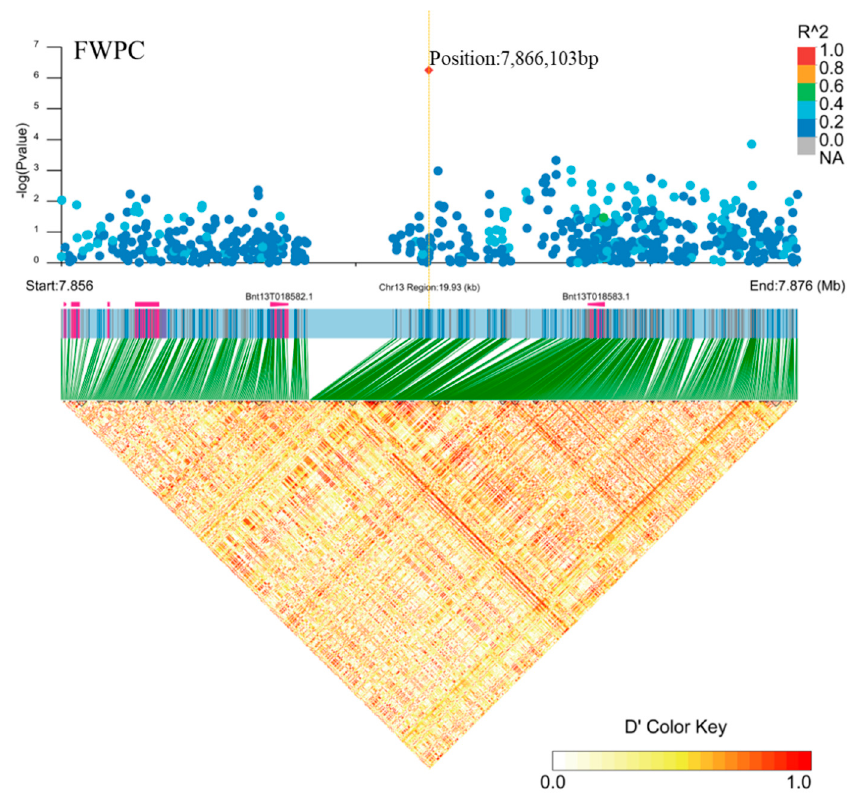
Figure 10. Candidate genes for FWPC (fresh weight per clump) on chromosome 13. Manhattan plot (top) and linkage disequilibrium heatmap (bottom) of genomic region surrounding Bnt13G018582 and Bnt13G018583 . A significant signal was associated with FWPC on chromosome 13, as assessed using EMMAX (Efficient Mixed-Model Association eXpedited), and it was between Bnt13G018582 and Bnt13G018583 . The graph shows genomic positions ( x axis) and the respective significance ex- pressed as − log 10 p value ( y axis). The genomic position spans ~20 kb on either side of the peak SNP (single nucleotide polymorphism), indicated by an orange dashed vertical line. The larger the R^2 (Coefficient of correlation) values (indicated in the legend on the top right), the stronger the degree of association. The red diamond indicates the associated SNP, and the lighter colors of the remaining markers reflect their successively lower R^2 values. D’ represents the correlation between different loci, the larger the value, the stronger the correlation and the higher the degree of linkage disequi- librium. The heat map showed that there was a strong linkage between the regions 7.856–7.876 Mb.